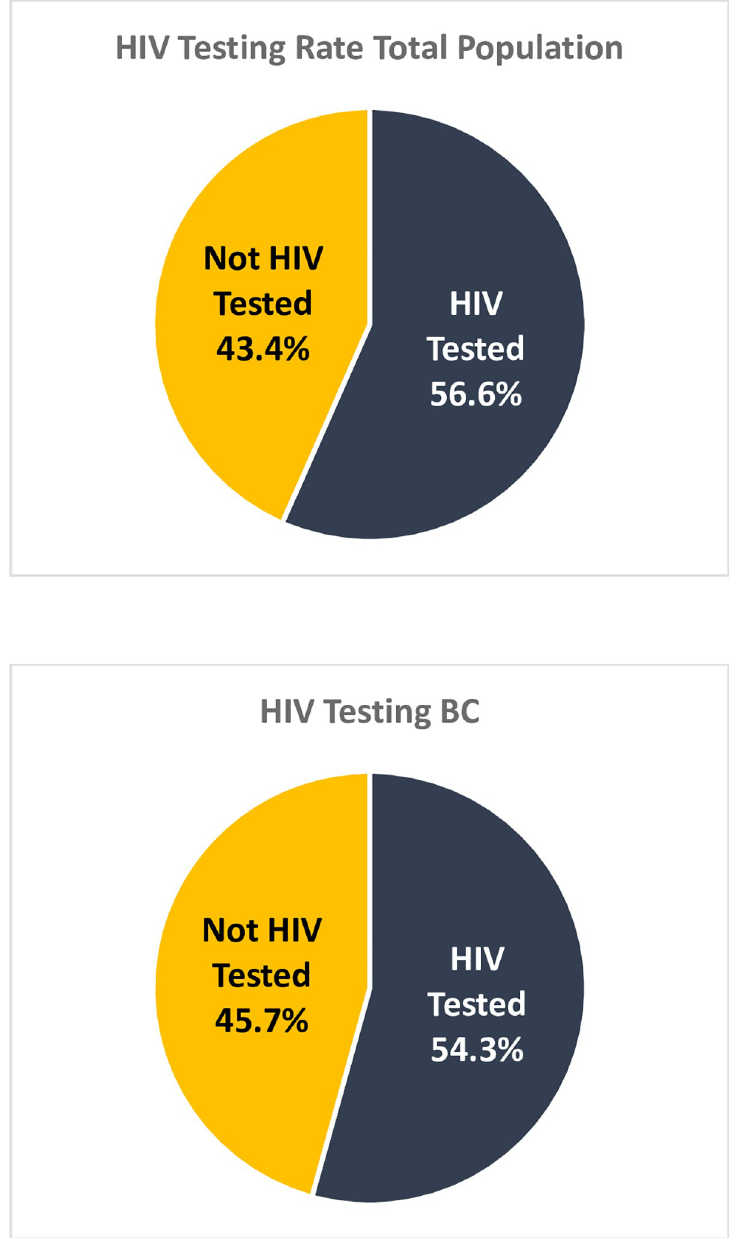
Fig 1. HIV testing in the HCV Ab+ population. This figure illustrates the rates of HIV testing rates for those in BC, non-BC, and study as a whole. Patients were not more likely to be tested for HIV is they were in the non-BC compared to the BC (p =